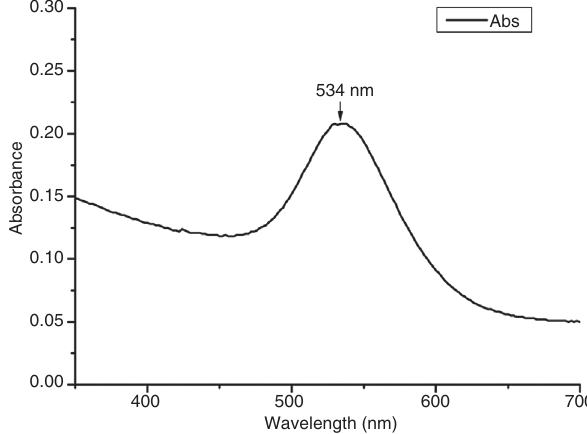
Figure 2 UV spectra of gold nanoparticles showing surface plasmon band at 534